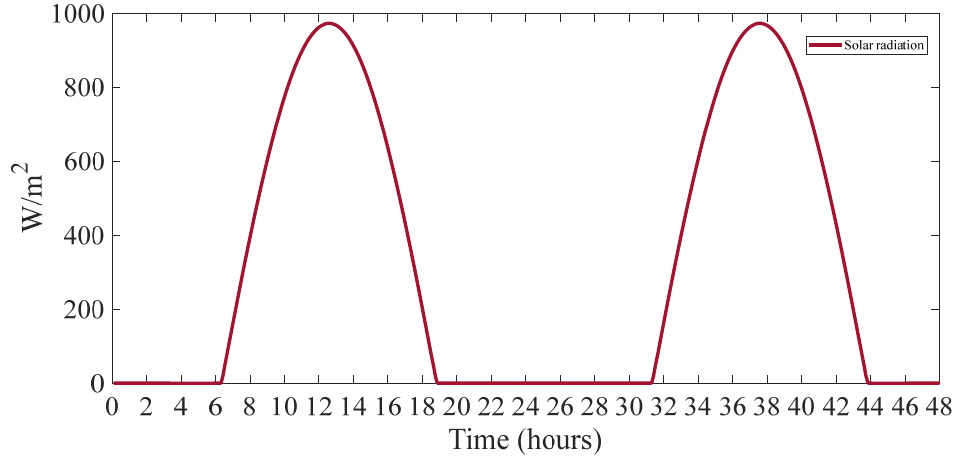
Figure 19. Solar radiation profile for a sunny day.